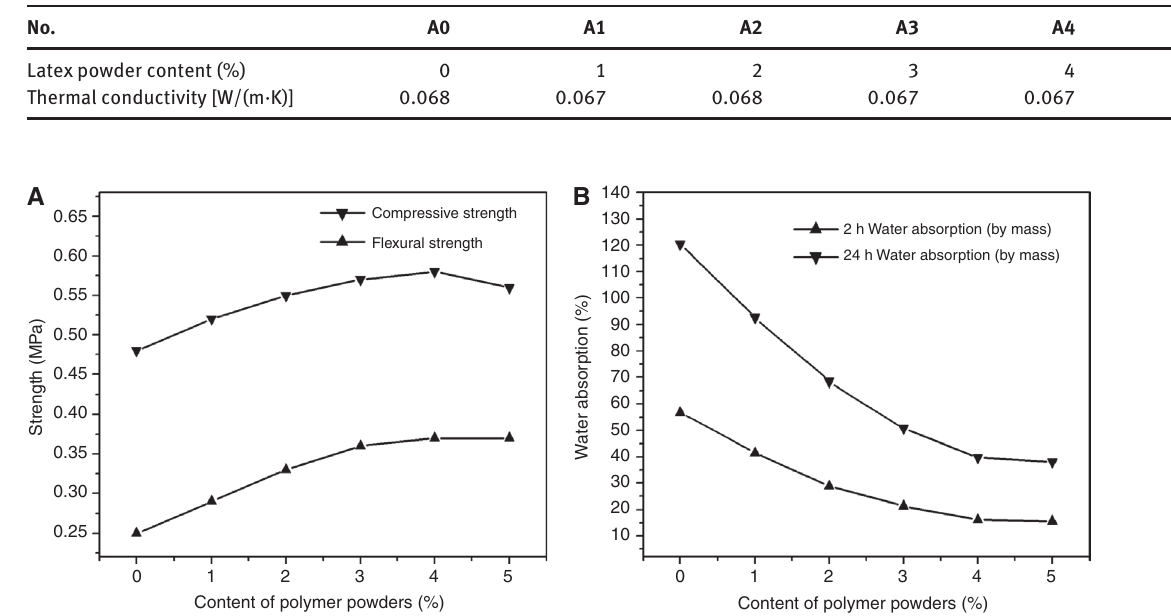
Figure 4 Effect of different contents of latex powder on the strength and water absorption of the samples. (A) Effect on the strength of the samples. (B) Effect on the water absorption of the samples.